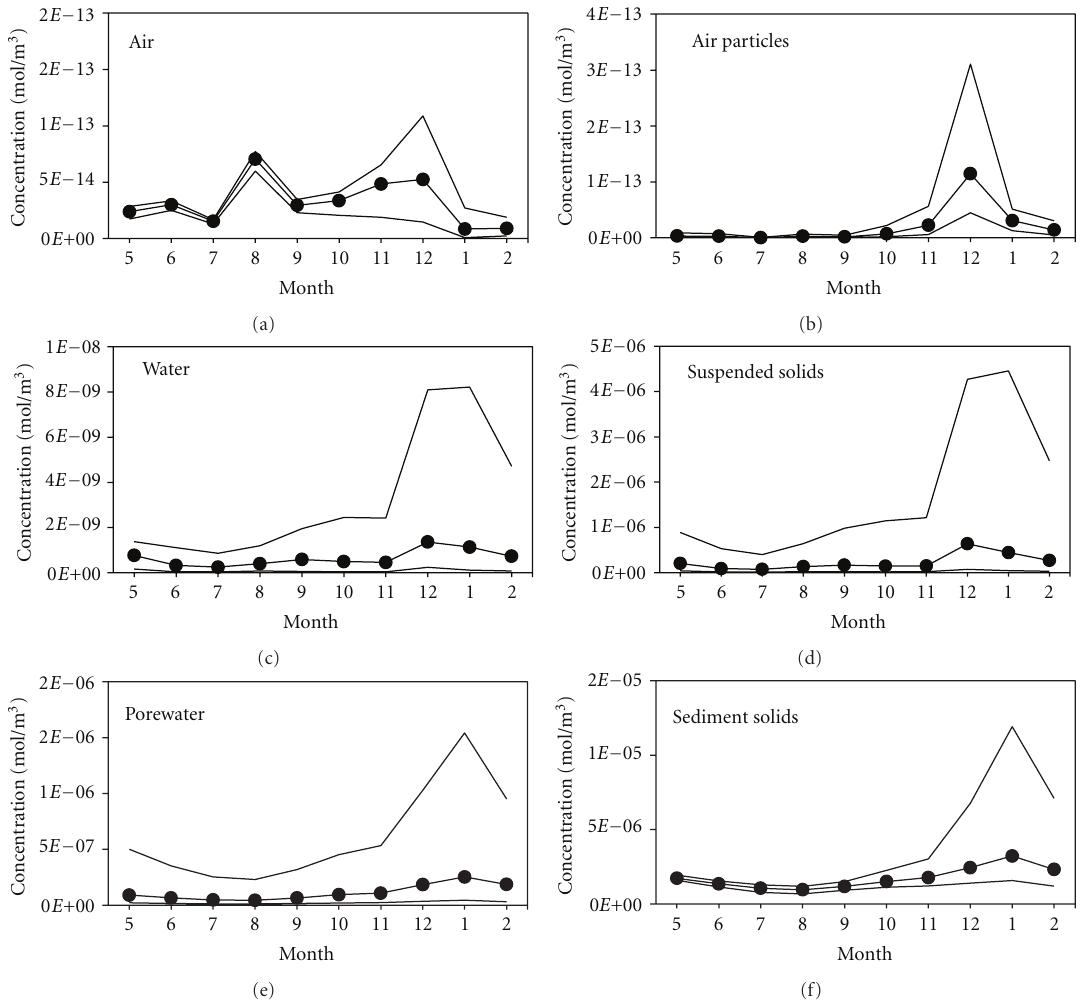
Figure 8: Uncertainties of the predicted seasonal variations of α -HCH concentrations in various environmental media. The results are presented as median values (lines with dots) and semi-interquartile ranges (solid